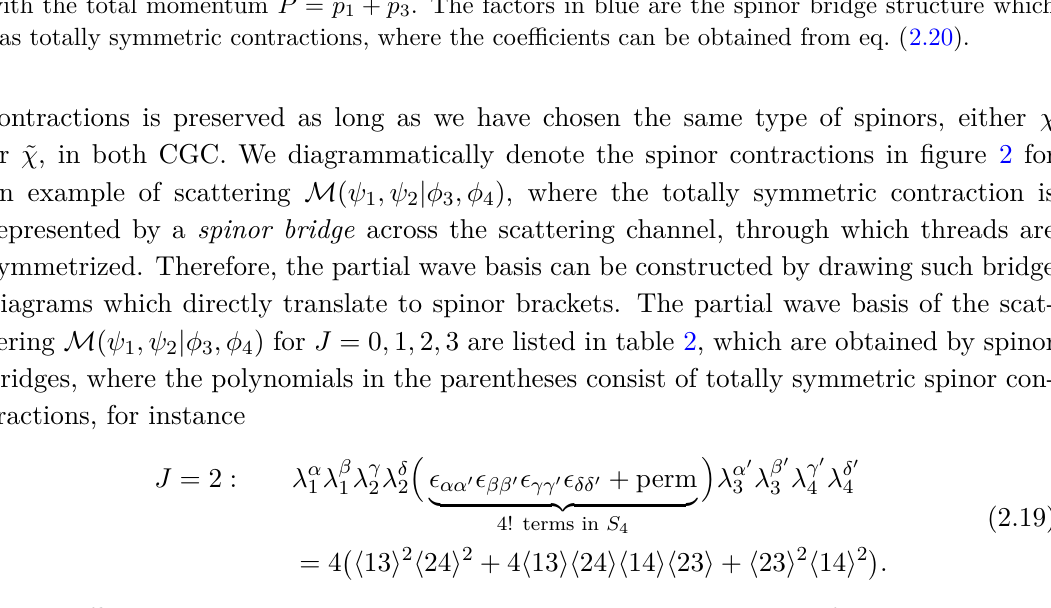
+ p . The factors in blue are the spinor bridge structure 1 3